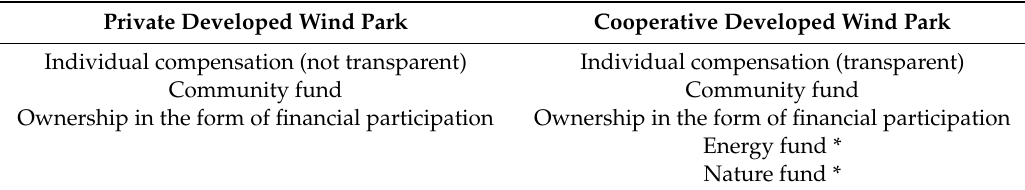
Table 7. Current modes of distribution of benefits of wind parks in